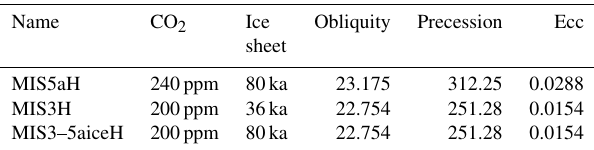
Table 1. Forcing and boundary conditions of the climate simula-